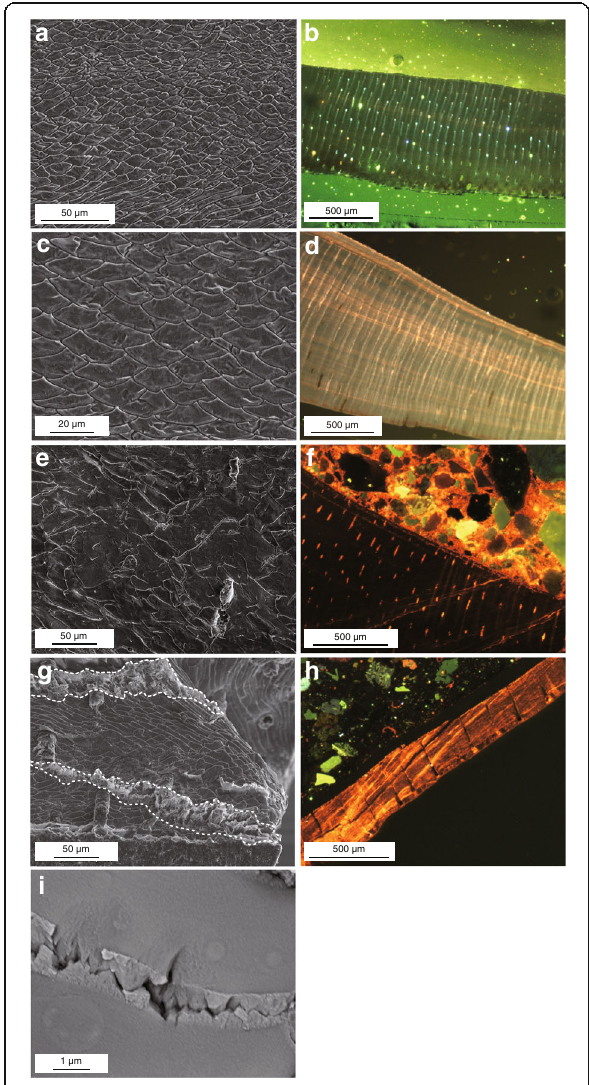
Fig. 4 SEM and CL images of shell microstructure observed in the studied brachiopod shells. a SEM image of modern Terebratalia coreanica (OTTCo). b CL image of modern T. coreanica (OTTCo)*. c SEM image of modern Laqueus rubellus shell (SGLR). d CL image of modern L. rubellus shell (SGLR). e SEM image of well-preserved shell microstructure of fossil T. coreanica (MNTCo3). f CL image in the shell portion adjacent to e , with luminescent punctae. g SEM image of altered shell microstructure (surrounded by dotted lines) in a fossil L. rubellus (MNLR2) shell. h CL image of the shell portion adjacent to g , showing bright luminescence. i SEM image of cement precipitated in the inter-fiber spaces of fossil T. coreanica (MNTCo1). Image brightness and contrast were adjusted with Adobe Photoshop software (Adobe Systems Incorporated, San Jose, USA) so that the luminescent bands become clearly